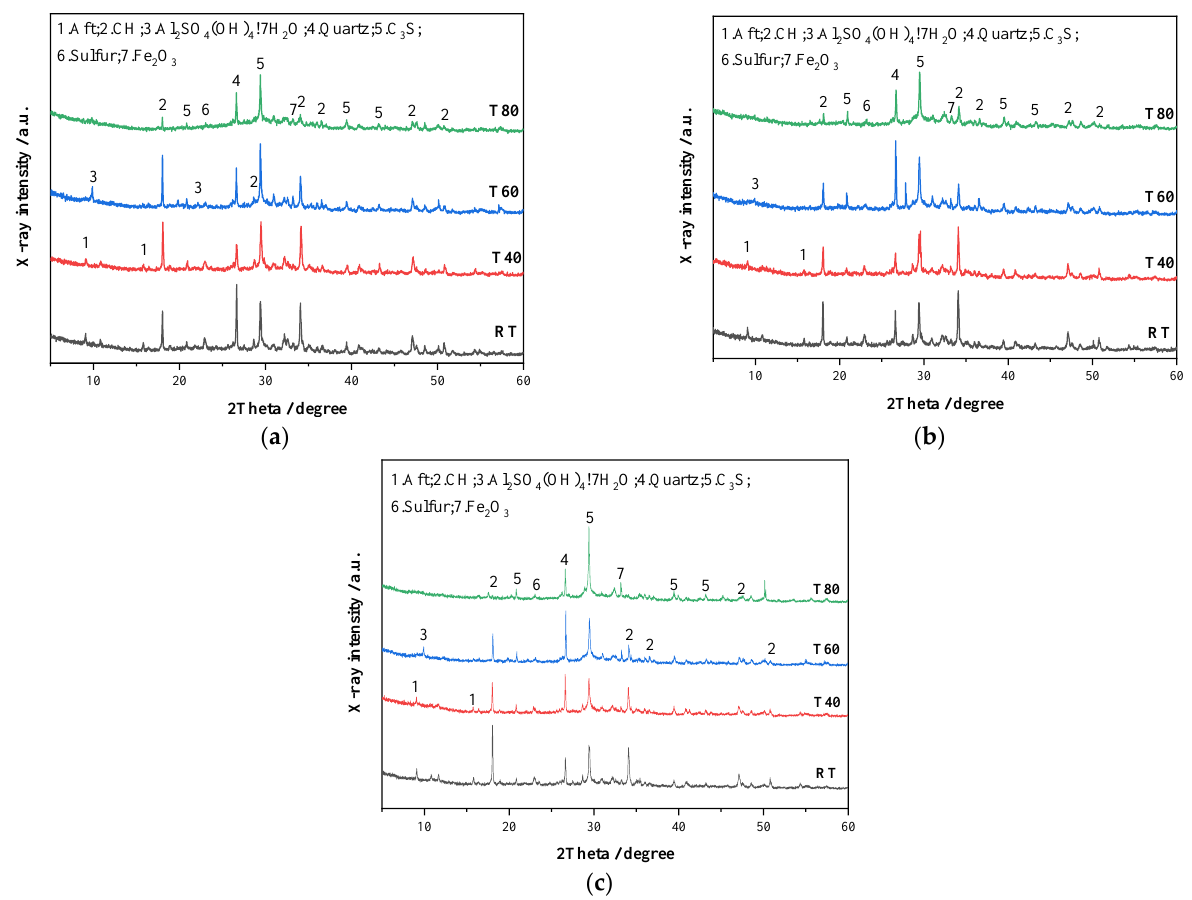
Figure 13. XRD patterns of mortars at different curing temperatures: ( a ) 3, ( b ) 7, ( c ) 28 days.